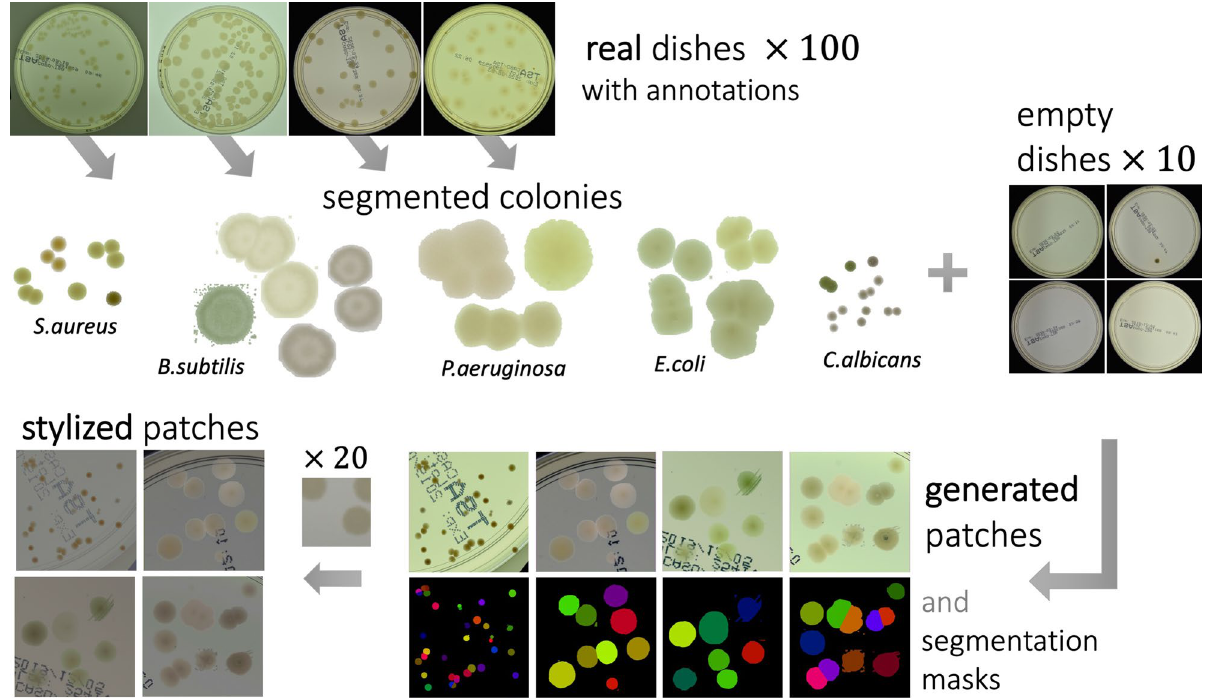
Figure 1. Scheme for synthetic microbial dataset generation. Microbial colonies are segmented from real images using traditional computer vision algorithms, and then randomly arranged on fragments of an empty dish giving synthetic patches with precise annotations. To improve the realism of generated data, patches are then stylized using a neural style transfer